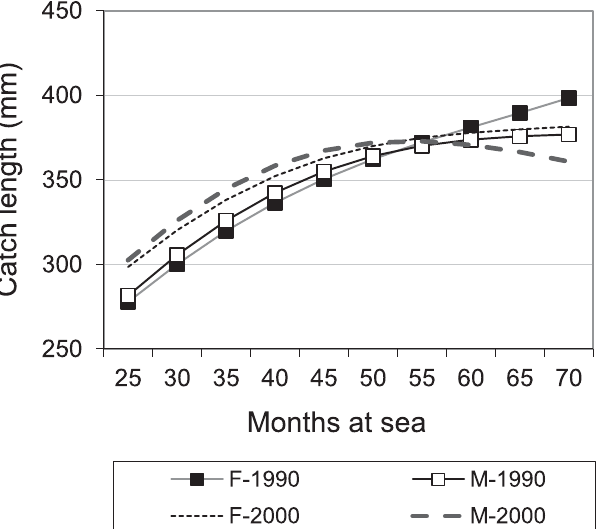
Fig. 4. Predicted length of individual anadromous female (F) and male (M) white fi sh ( Coregonus lavaretus ) in relation to time (months) spent at sea in two year-class periods (1996 – 2002, 2003 – 2009; symbols: 1990 and 2000, respectively) in the Gulf of Bothnia according to linear regression model. The white fi sh captured by trap and gill nets in the third-sixth sea year (25 – 72 months; 25 – 36 months =the third year; 37 – 48 =the fourth year, 49 – 60= the fi fth year, 61 – 72 =the sixth year) are included (sample size = 12653). The length is log-transformed (natural) in the model, but transformed back to linearity in the fi gures. Sample size for earlier and later periods, n =6151 and n = 6516, respectively (Tab. A.4).